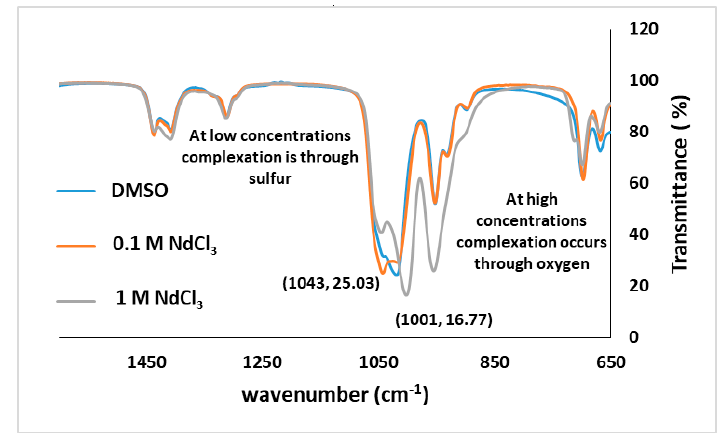
Figure 3. Infra-Red spectra for pure dimethyl sulfoxide (DMSO) (in blue line), DMSO_0.1 M NdCl 3 (in orange line), and DMSO_1 M NdCl 3 (grey line).